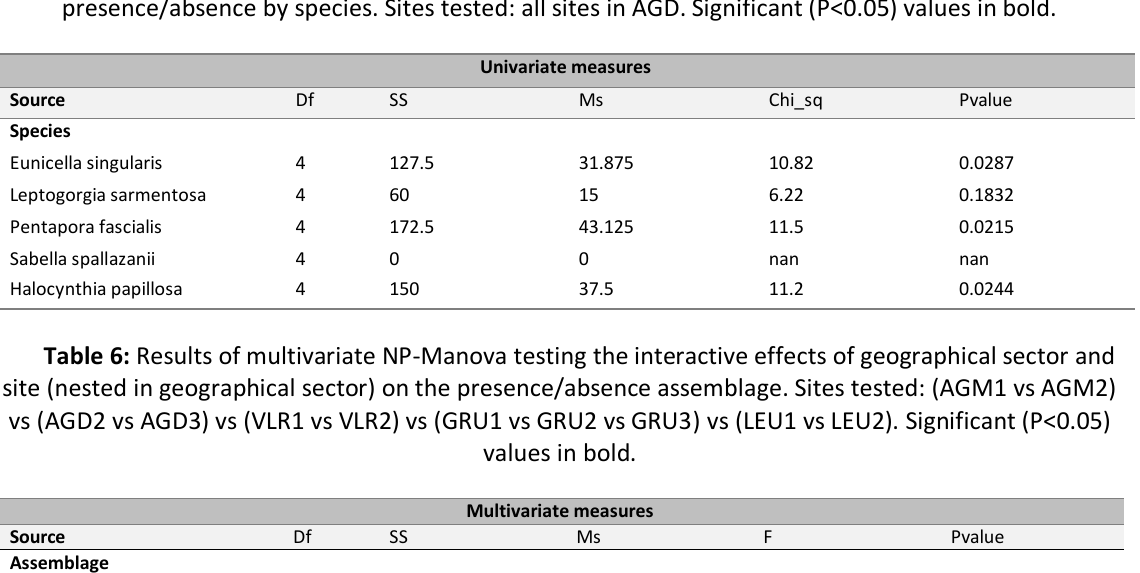
Table5: Results of univariate Kruskall-Wallis testing the effect of location of deployment on the presence/absence by species. Sites tested: all sites in AGD. Significant (P<0.05) values in bold.